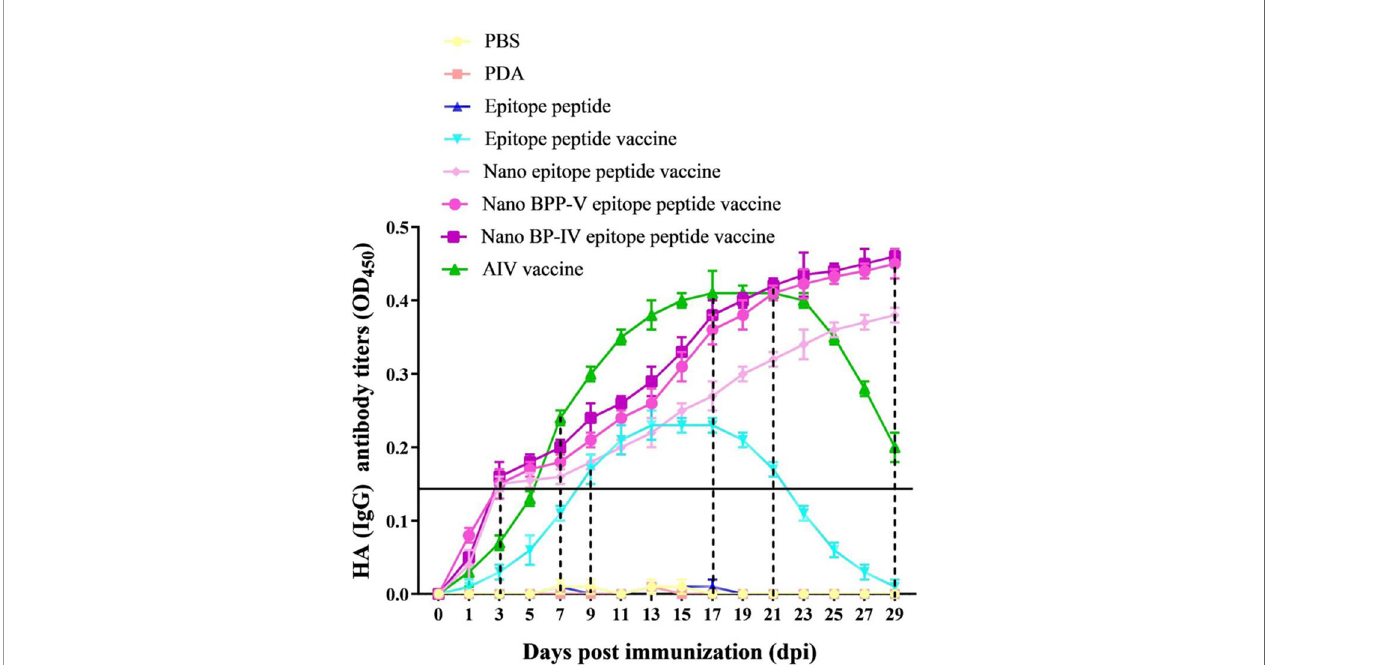
FIGURE 4 | Changes in the anti-HA (IgG) antibody levels in mouse serum after immunization. The mice were immunized on day 0, and the anti-HA (IgG) levels in immunized mouse serum were detected on days 1, 3, 5, 7, 9, 11, 13, 15, 17, 19, 21, 23, 25, 27, and 29 after the immunization to evaluate the antibody